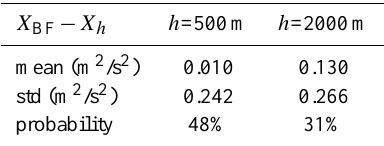
Table 4. Mean, std of X BF − X h for h =500, 2000m, and probability that convection reaches that depth assuming that X BF − X h follows a normal distribution. X BF − X